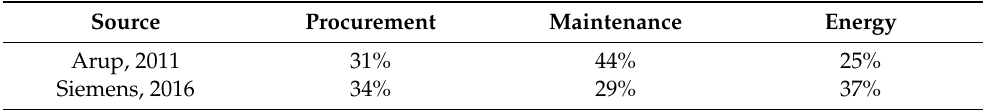
Table 1. Lifecycle components’ value.